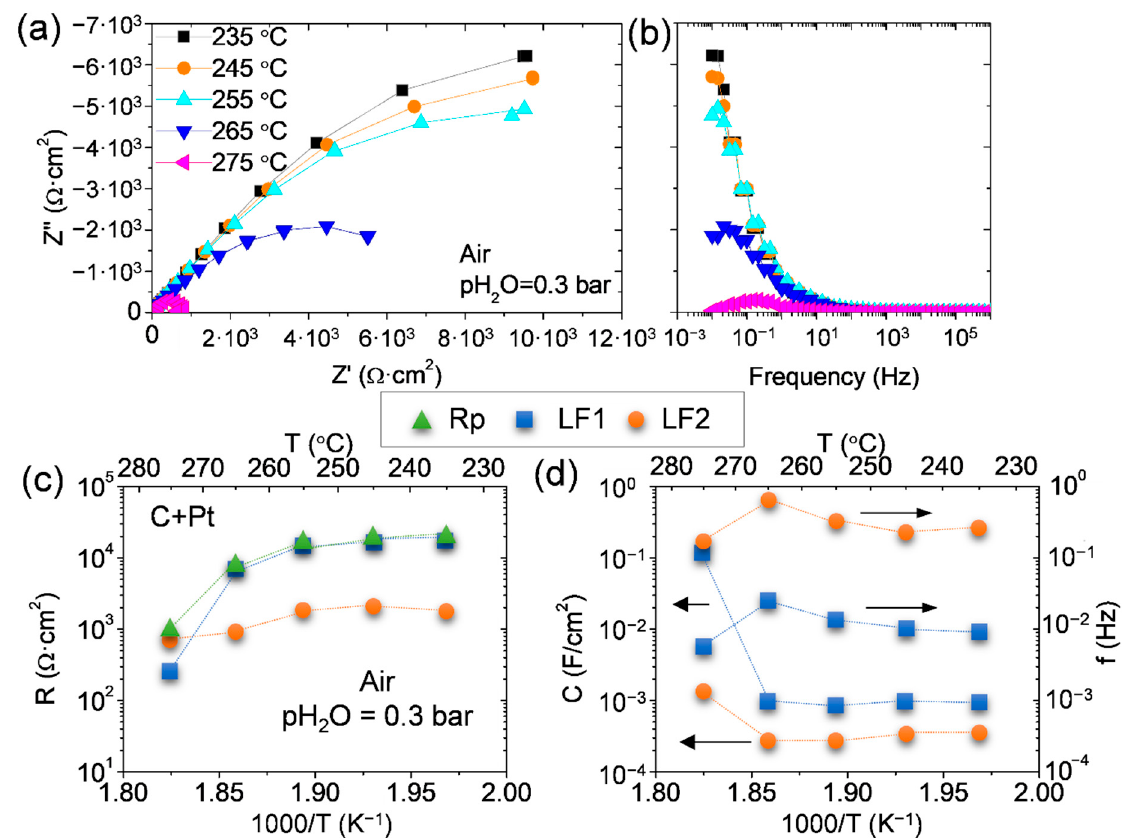
Figure 7. ( a ) Nyquist’s and ( b ) Bode’s plots and equivalent electrical circuit fitting results; ( c ) resistance and ( d ) capacitance and frequency of Pt on C paper symmetrical cell as function of temperature in air conditions with pH 2 O = 0.3 bar.